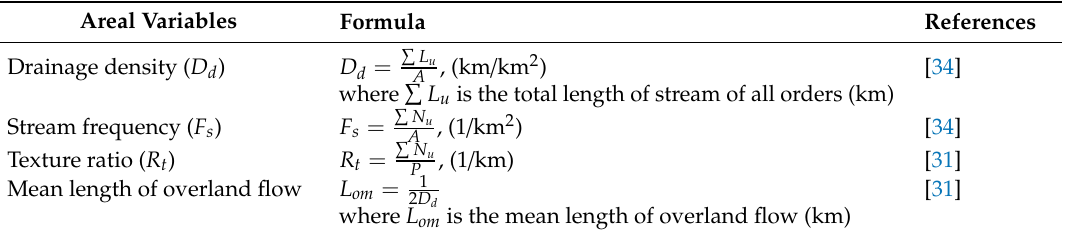
Table 2. Areal morphometric variables computation formulae with references.